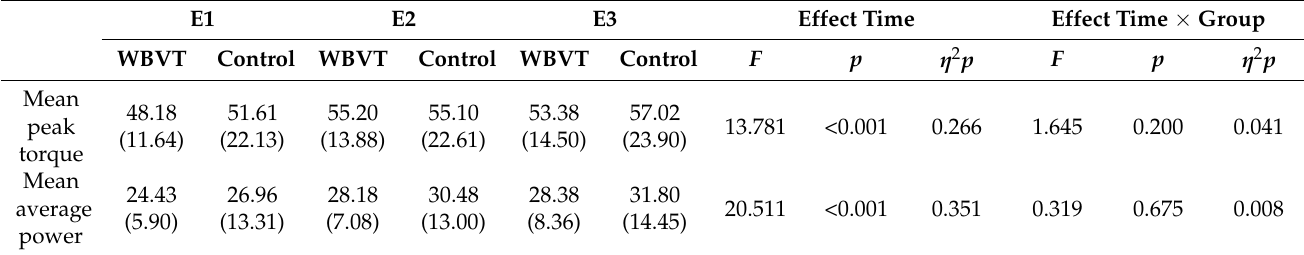
Table 2. Primary outcome measures (Isokinetic dynamometer).